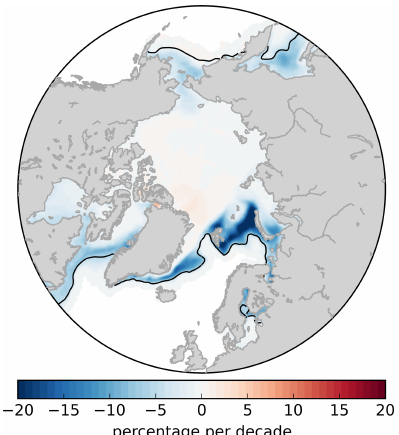
Figure 3. The winter (DJF) Arctic sea-ice concentration trend in ERA5 over the period of 1980–2019. Black contour indicates the sea-ice extent climatology for 1980–2000.